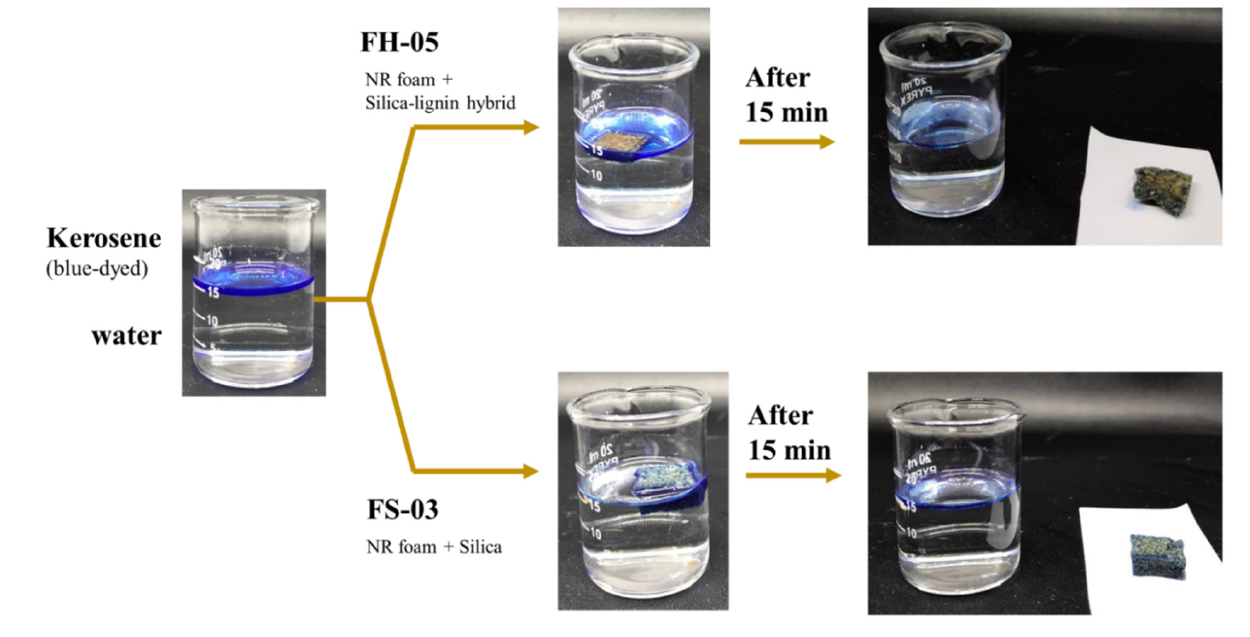
Figure 12. Demonstration of oil–water separation using the optimum silica-filled and silica–lignin hybrid-filled NRF samples.